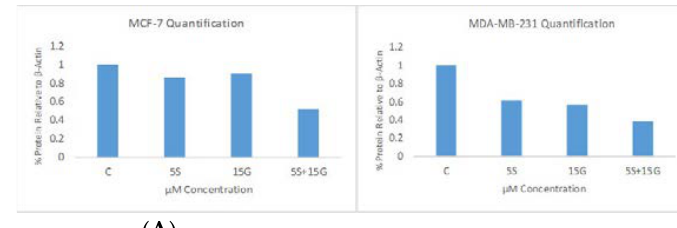
Figure 9. KLF4 Western blot. KLF4 protein levels are downregulated by GEN and SFN in breast cancer cell lines: ( A ) combinatorial GEN and SFN downregulates KLF4 protein expression in MCF-7 and MDA-MB-231 breast cancer cells with the combination appearing to be the most effective. Results of densitometry analyses of the aforementioned western blots using ImageJ software; ( B ) combinatorial GEN and SFN downregulates human telomerase reverse transcriptase (hTERT) protein expression in MCF-7 and MDA-MB-231 breast cancer cells. Results of densitometry analyses of the aforementioned Western blot using ImageJ software (version 1.51k, NIH, Bethesda, MD, USA). The figures are representative of similarly performed experiments ( n = 3). The densitometry analysis was done of the representative figure.